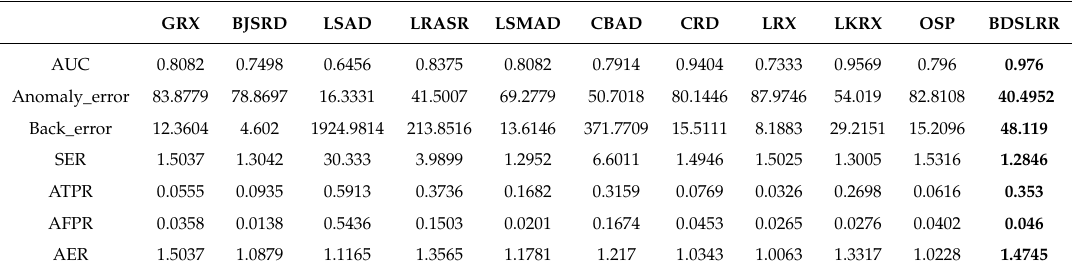
Table 2. San Diego Dataset: Assessment Metric Summary.